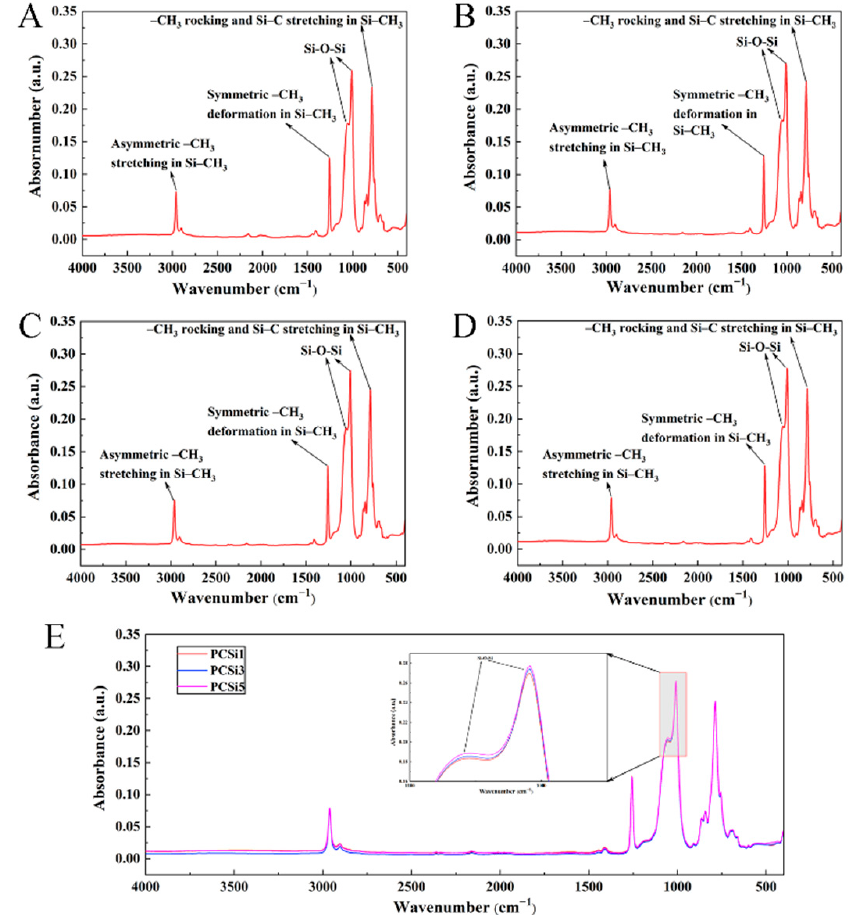
Figure 4. FTIR spectrum of pure PDMS ( A ), PCSi1 ( B ), PCSi3 ( C ), PCSi5 ( D ) and comparison of MWCNTs-COOH and SiO 2 -treated samples ( E ).